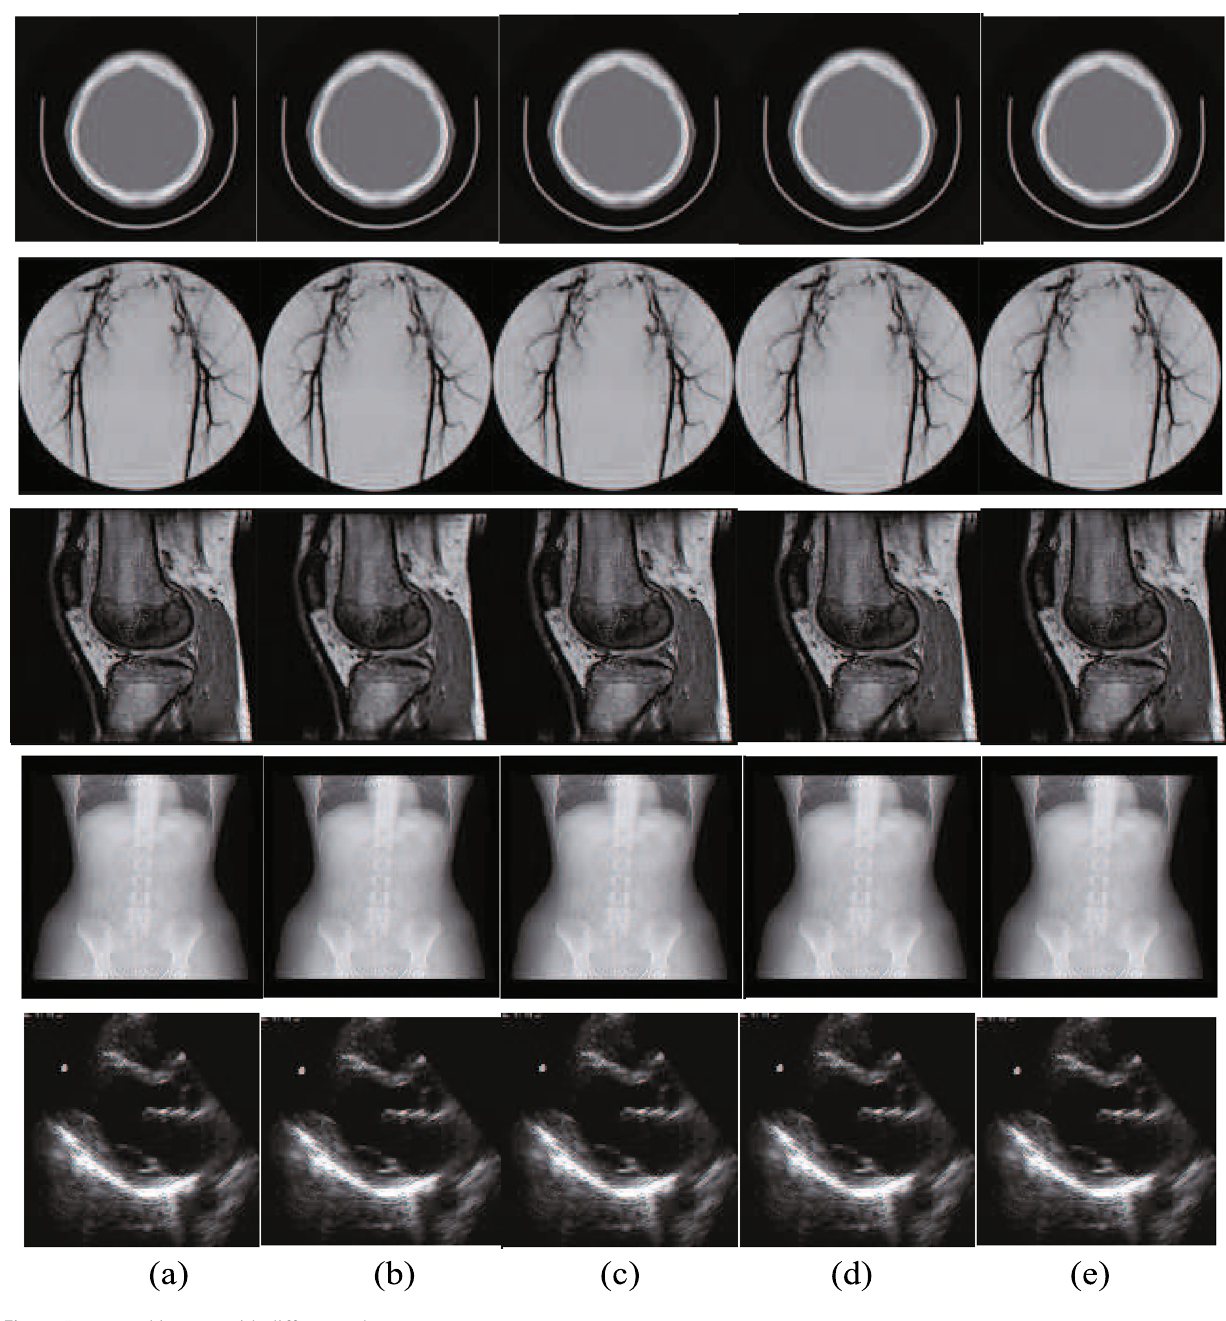
Fig. 8 Decrypted images with different schemes